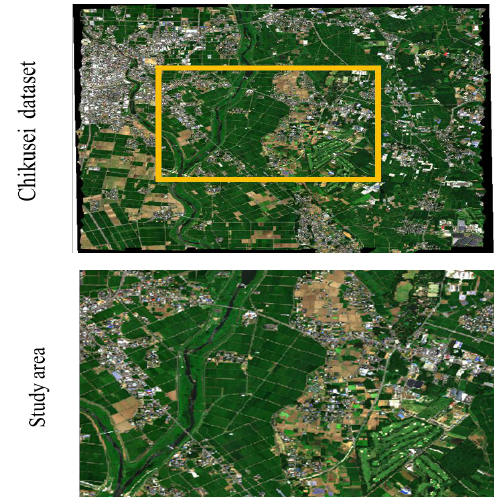
Figure 5 . Chikusei dataset. The experimental subset is located in the yellow rectangle.